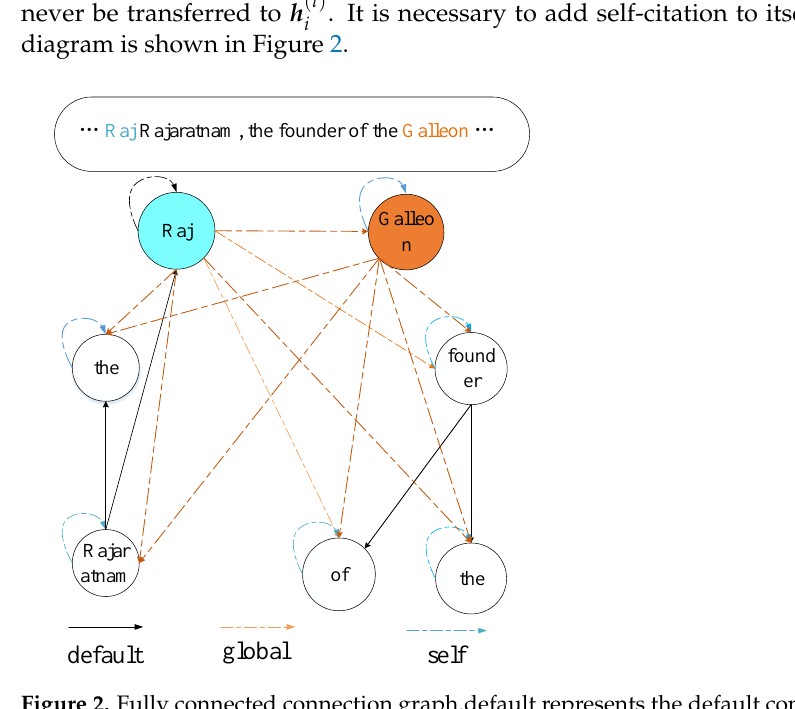
Figure 2. Fully connected connection graph.default represents the default connection in the gram- matical dependency tree, global represents the entity node and other nodes have corresponding connections, self represents